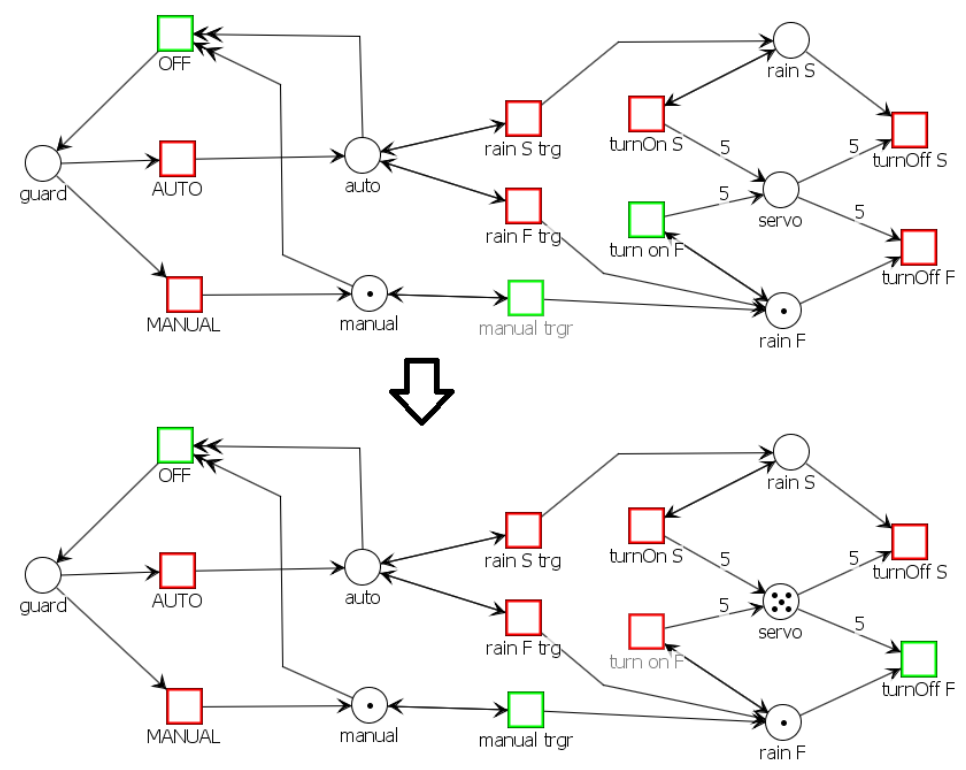
Figure 13. Petri net for control of laboratory car wiper system—the action of